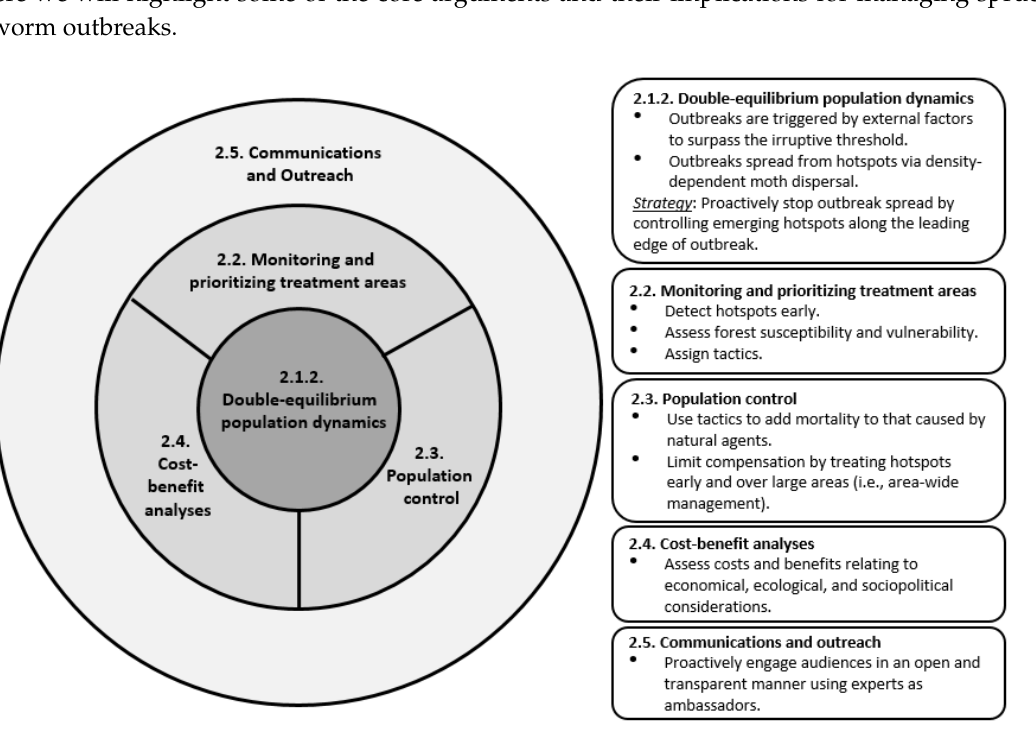
Figure 1. A conceptual framework for Spruce budworm Early Intervention Strategy (EIS) program illustrating the relationships between its different components. Double-equilibrium population dynamics provides the core ecological justification for EIS. In turn, the aims of EIS dictate monitoring and treatment prioritization protocol, population control practices and tactics, and the criteria used in cost–benefit analyses. These particular components are highly dependent upon one another, in that challenges or innovations in one component will likely influence the e ffi cacy or feasibility of the others. Proactive communications and outreach are essential for disseminating information and garnering social license to allow all other aspects of the program to operate. Numbers denote the section of each topic within the body of the